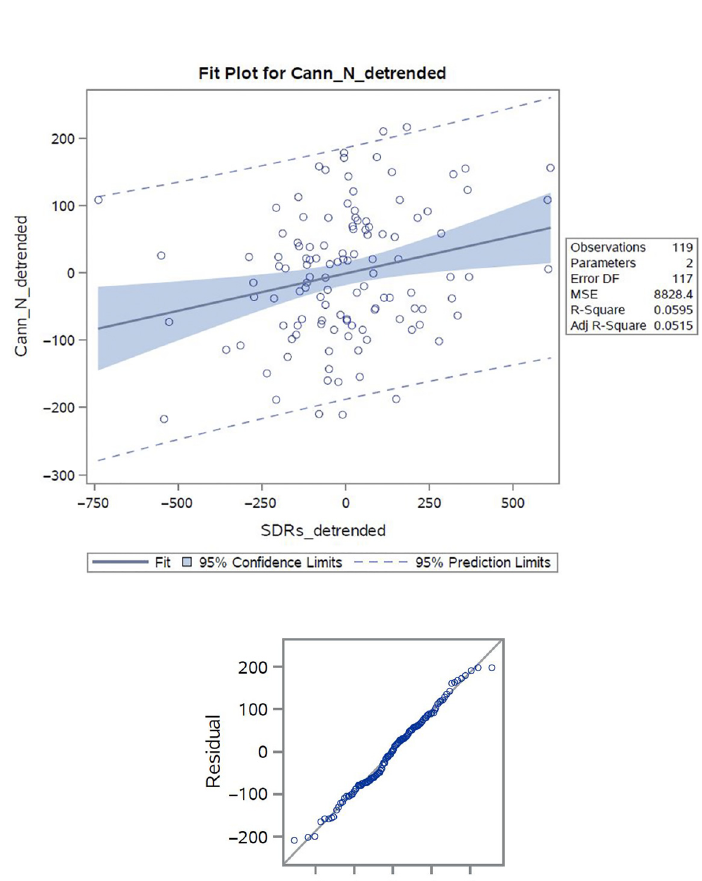
Figure 5. ACC Cann QQ